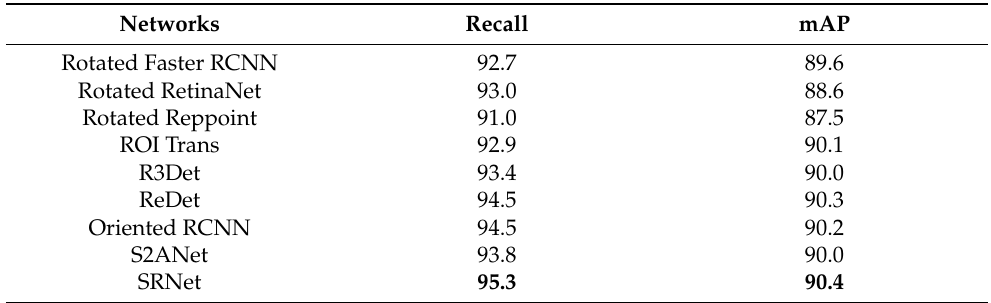
Table 1. Rotated object detection performance of different networks on the SSDD